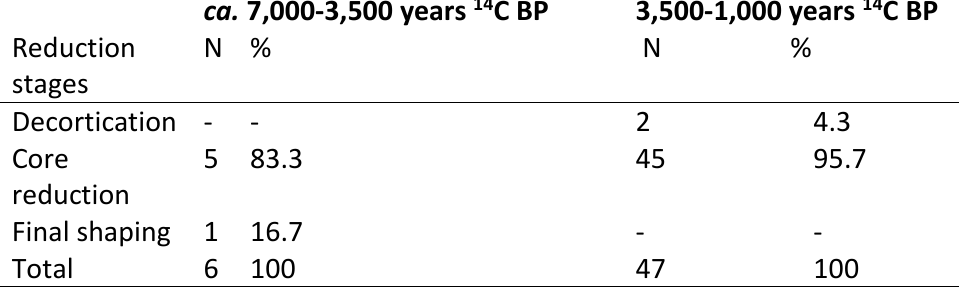
Table 5. Artifact frequencies according to reduction stage.